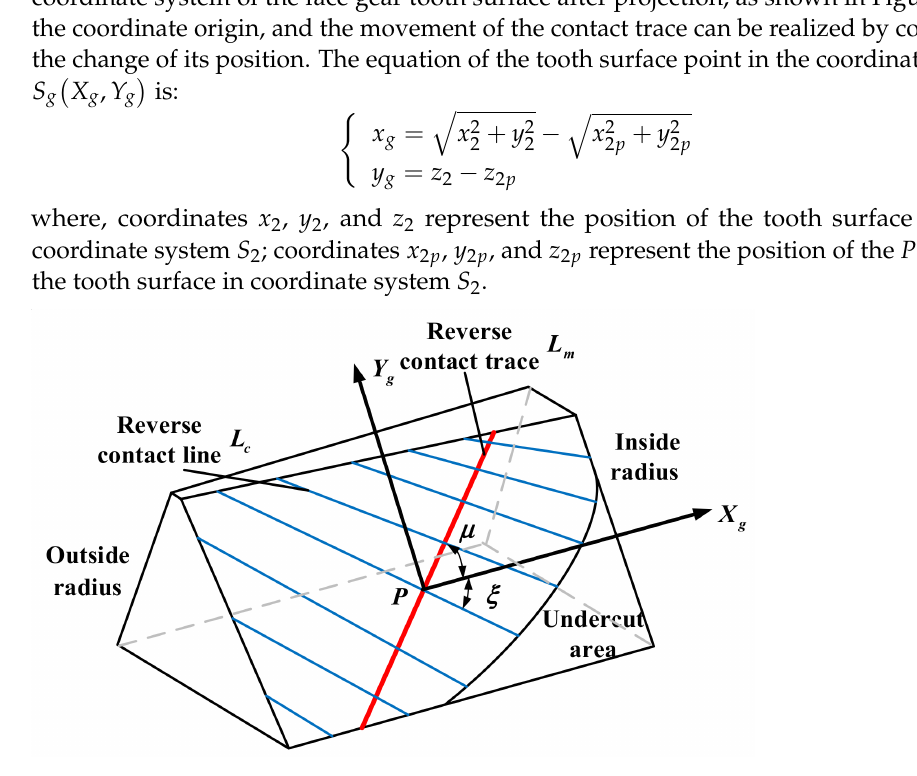
Figure 4. Schematic diagram of face gear tooth surface in coordinate system